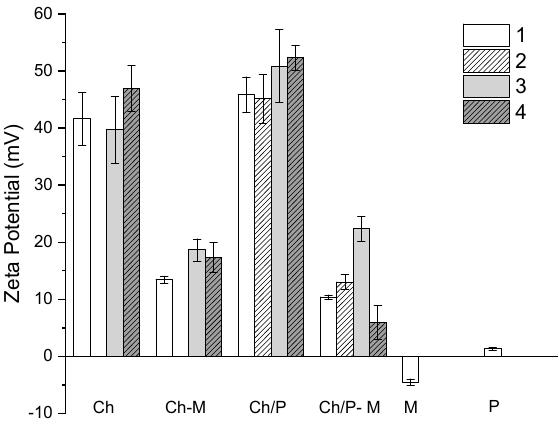
Figure 3. Zeta potential of Ch ’ s (samples 1, 2, 3, 4), Ch–M, Ch/P , Ch/P –M, M (mucin) and P (phospholipids) solutions. Presented results are average of at least three independent experiments ( n = 3) and are presented as a mean ± standard deviation.